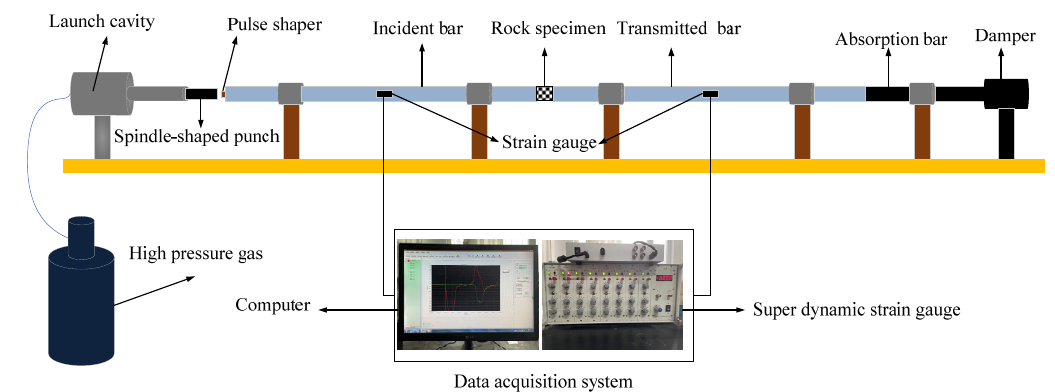
Figure 1. Diagram of the split Hopkinson pressure bars (SHPB) experimental system.